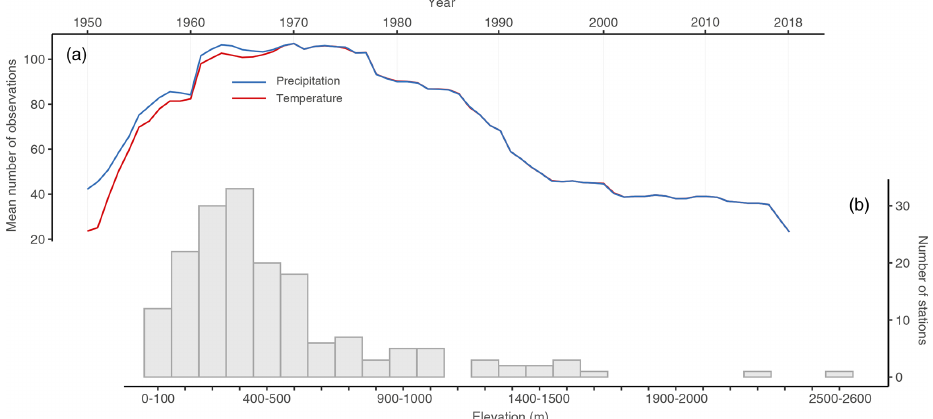
Figure 2. Original data: (a) mean annual number of observations of precipitation and temperature, and (b) number of stations by elevation